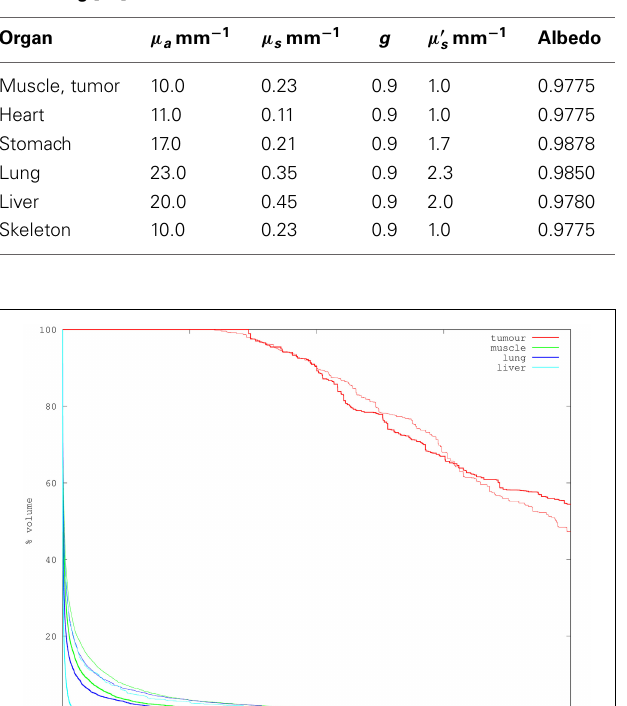
Table 4 | Selected simulation optical properties, as provided in Shen and Wang [21].